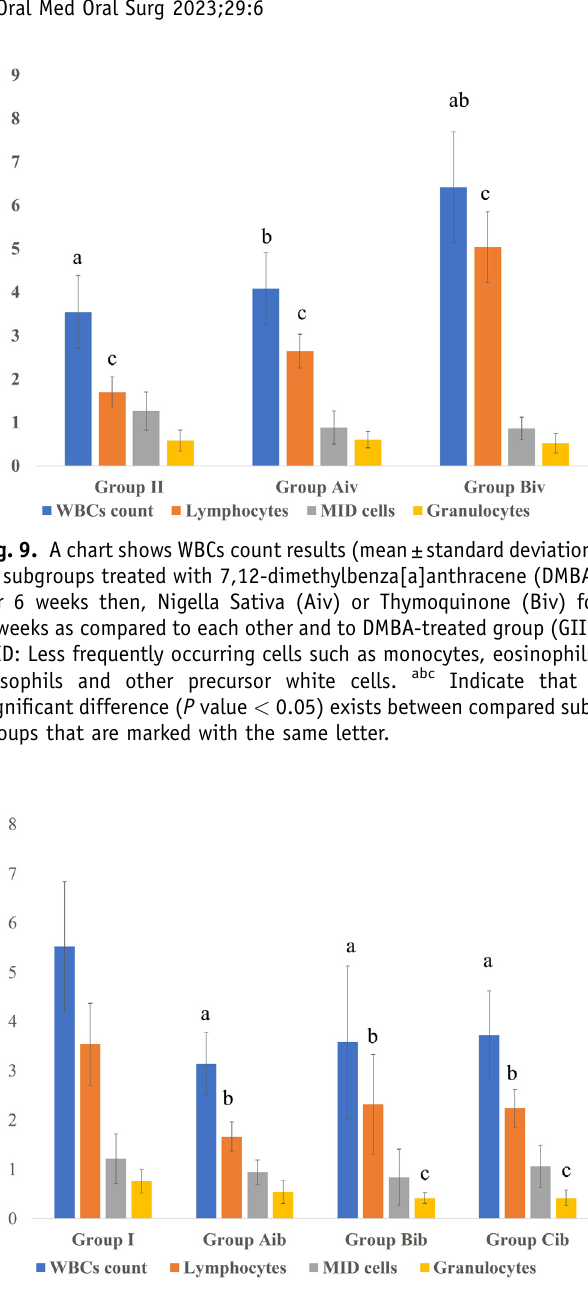
Fig. 10. A chart shows WBCs count results (mean ±standard deviation) of subgroups treated for 2 weeks with either Nigella Sativa (Aib) or Thymoquinone (Bib) or ( – )-Epigallocatechin-3-gallate (Cib), thenwith 7,12-dimethylbenza[a]anthracene(DMBA)for6weeks as compared to healthy untreated group (GI). MID: Less frequently occurring cells such as monocytes, eosinophils, basophils and other precursor white cells. abc Indicate that a signi fi cant difference ( P value < 0.05) exists between compared subgroups and group I.